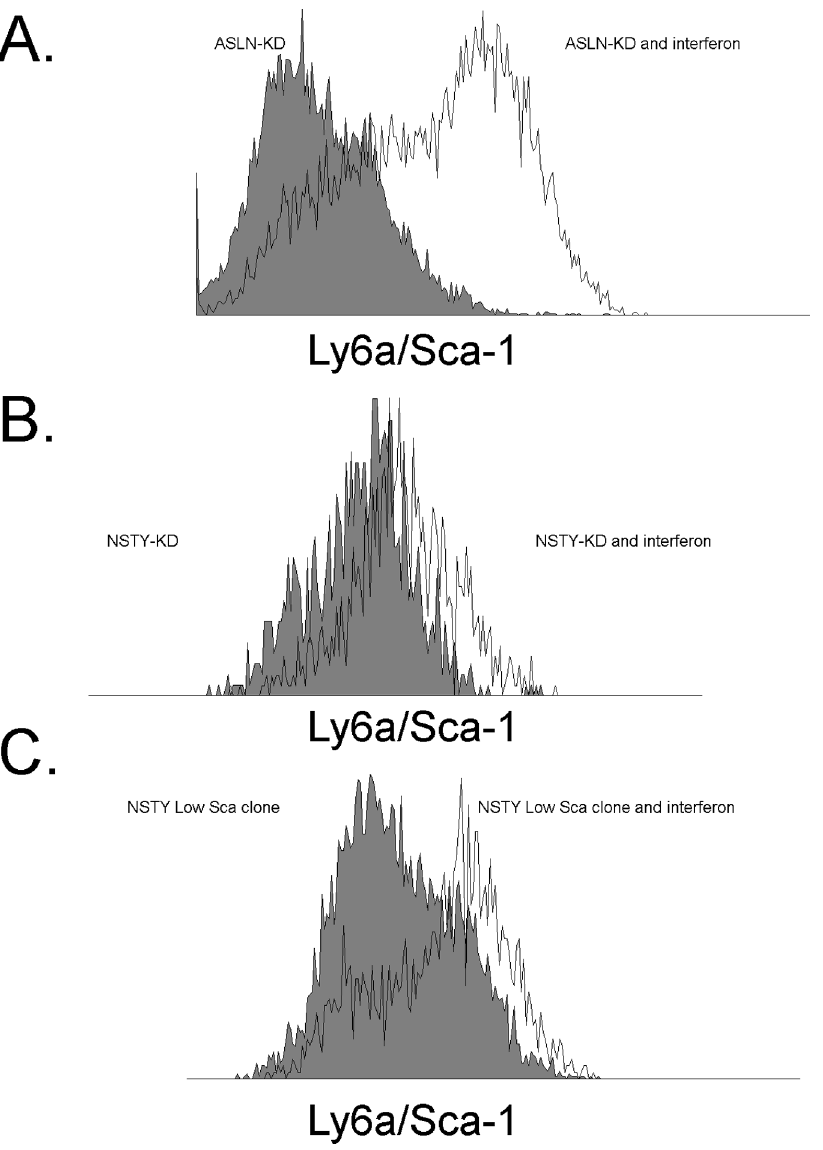
Figure 2. Higher levels of Ly6a/Sca-1 expression can be induced by interferon-gamma in Ly6a/Sca-1-knockdown leukemias and in low Ly6a/Sca-1 clones. Cells were treated with interferon-gamma 10 ng/ml for 24 hours. Controls were cultured 24 hours without interferon- gamma. Ly6a/Sca-1 was measured by flow cytometry. Filled histograms are controls without interferon while the unshaded histograms are the leukemias treated with interferon-gamma. (A) ASLN-lentiviral-Ly6a/Sca-1 knockdown. (B) NSTY-lentiviral-Ly6a/Sca-1 knockdown. (C) Low Ly6a/Sca-1 NSTY clone 8.